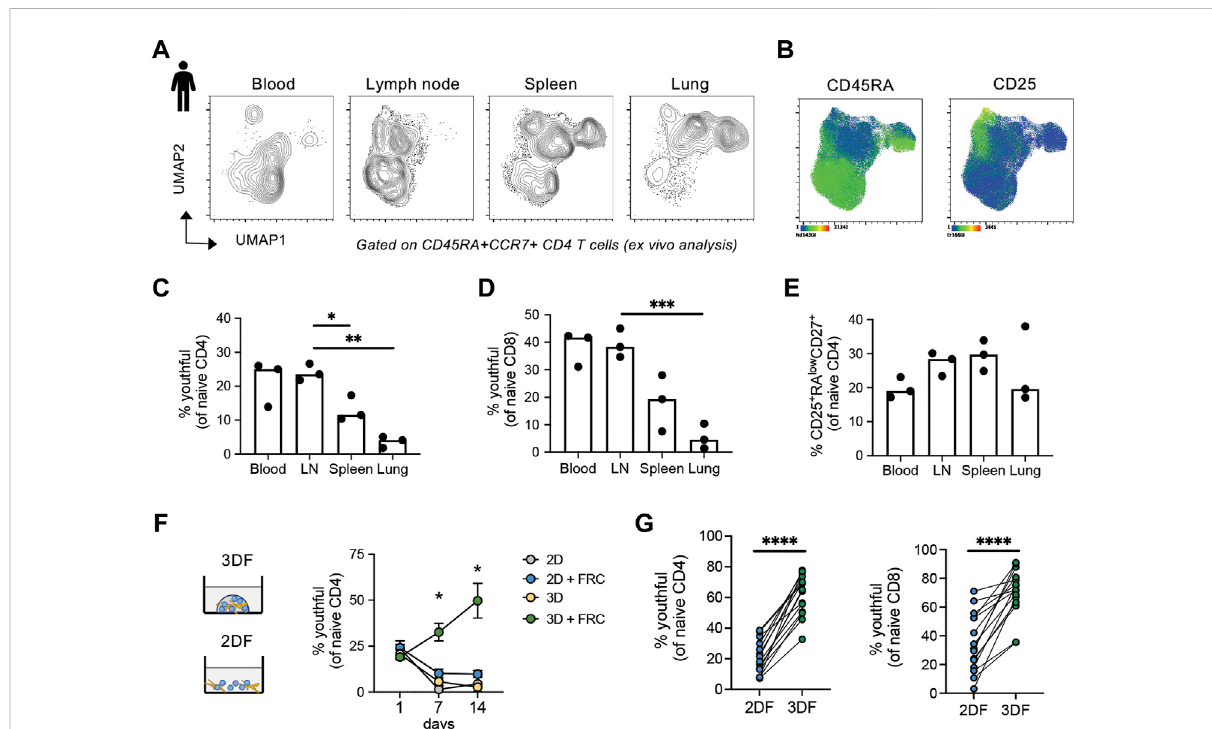
FIGURE 5 CD45RA high naïve T cells are enriched in human blood, lymph nodes and SLT-like organoids. (A) UMAP of naïve CD4 T cells across different tissue types from young adults ( n = 3). (B) Markers expression within naïve CD4 T cells from tissues. (C – E) Frequencies of (C) CD45RA high CD27 high CD38 + CD25 neg and (D) CD25 + CD45RA low CD27 low naïveCD4and (E) CD45RA high CD27 high CD38 + CD25 neg naïveCD8Tcellsacross tissue type. Mass cytometry dataset is from publicly available source ImmPort SDY1389. (F) Frequencies of CD45RA high CD27 high CD38 + CD25 neg naiveCD4Tcellsovertimeacrossdifferentcultureconditions( n =3youngdonors). (G) FrequencyofCD45RA high CD27 high naïveCD4andCD8Tcells inlargercohortof young donors ( n = 15) atday 14 in either 2DF or 3DFconditions.* p < 0.05, ** p < 0.01, *** p < 0.001, **** p < 0.0001. p -values were determined by (C – E) one-way ANOVA and (F,G) paired t